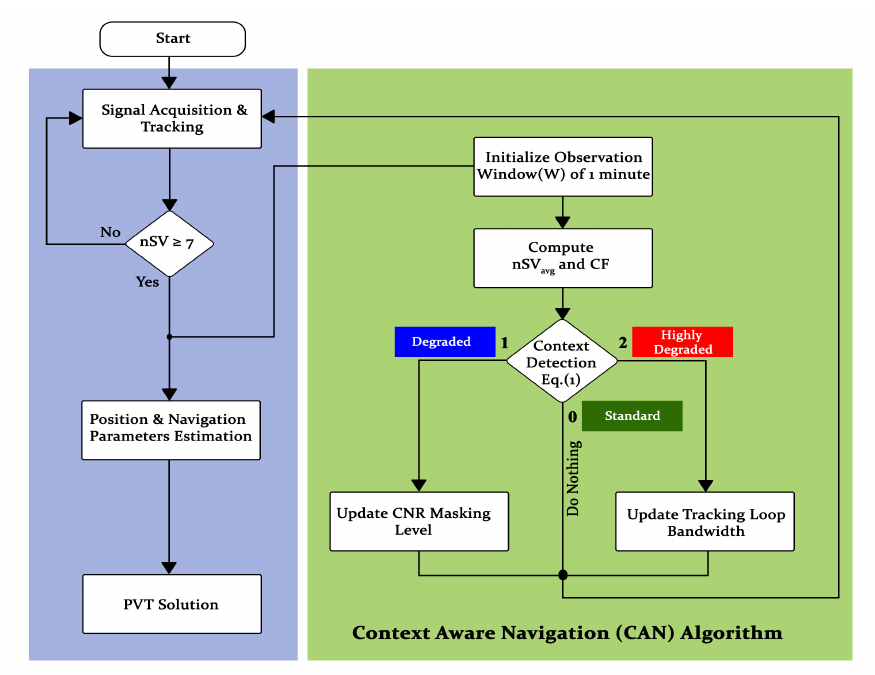
Figure 6. A complete workflow of the context-aware navigation (CAN) algorithm, which can detect and characterize the working environment of a GNSS receiver into three categories and then apply an appropriate mitigation strategy as per the detected